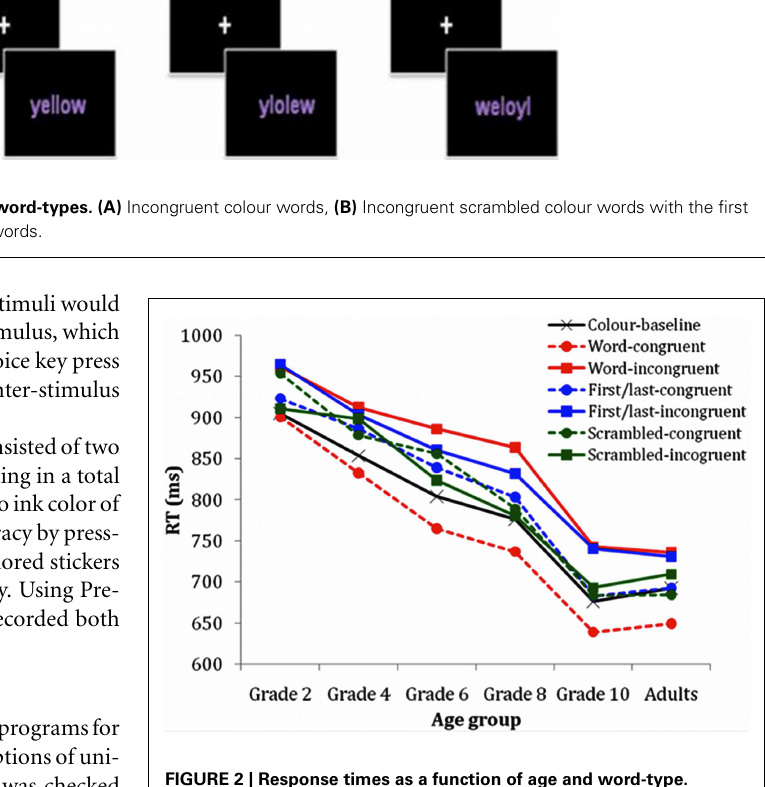
FIGURE 2 | Response times as a function of age and